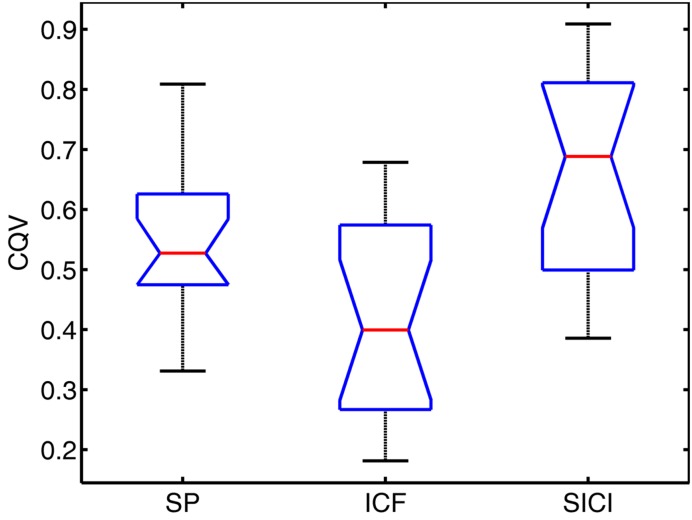
Notched boxplots for coefficient of quartile variation (CQV) in each TMS condition. Red lines show the median values. Bottom and top lines of the boxes represent the lower and upper quartiles of the data, respectively. Lower and upper whiskers denote the minimum and maximum CQV values, respectively. Notches show 95% confidence interval of the median value.